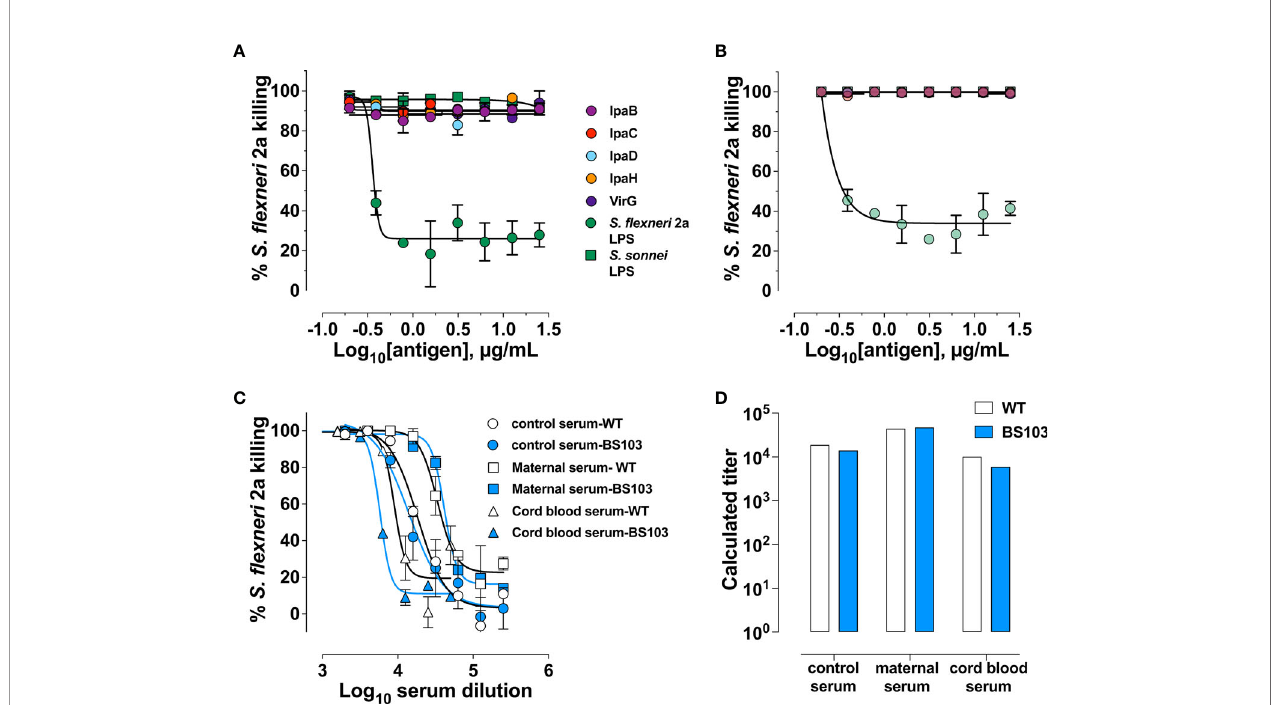
FIGURE 5 | Shigella LPS-speci fi c antibodies are the main contributors of bactericidal activity. Percent killing of S. fl exneri 2a in a representative maternal (A) and cord blood (B) serum pair depleted of antigen-speci fi c antibodies. (C) Killing curves of either wild-type (WT) S. fl exneri 2a 2457T (clear symbols) or S. fl exneri 2a BS103 (virulence plasmid-cured strain, shaded symbols) by hyperimmune control serum (control) and a representative maternal or cord blood serum pair at different dilutions. (D) Bactericidal titers of serum against S. fl exneri 2a WT (clear bars) or BS103 (shaded bars).